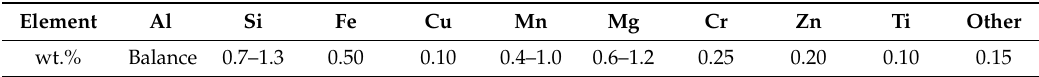
Table 1. Chemical composition of AMs.